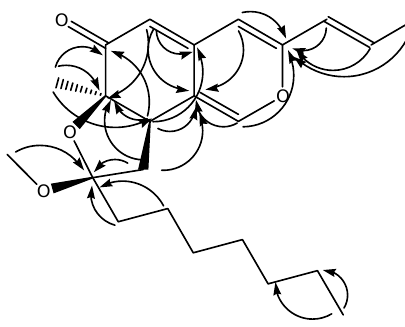
Figure 3. Key HMBC correlations of monapurfluore A. OO O